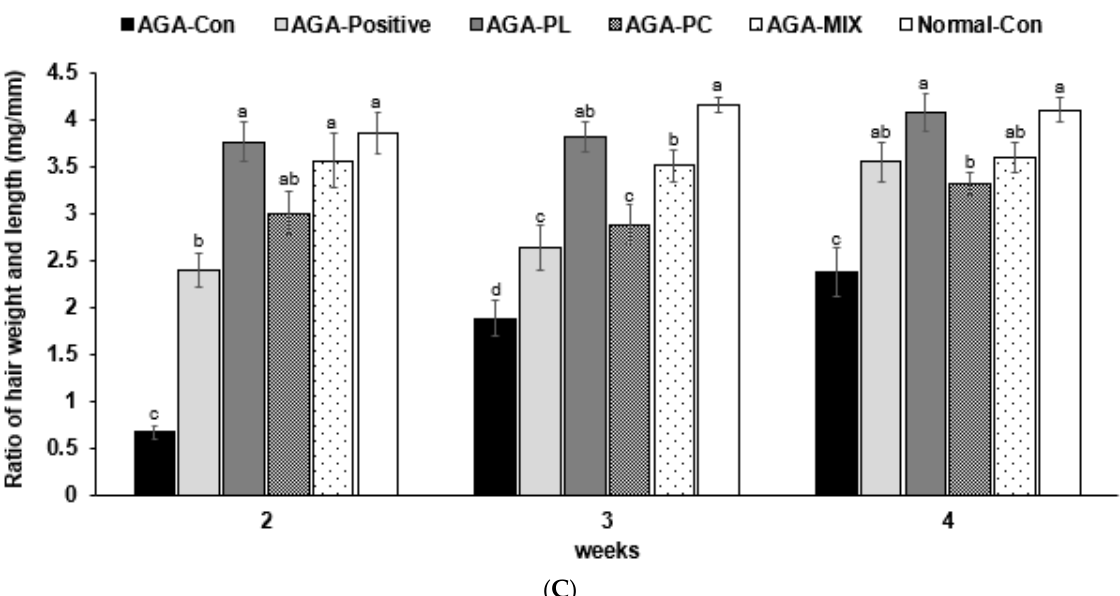
Figure 3. Severities of AGA symptoms. ( A ) Changes in AGA symptoms of dorsal skin lesions between treatment start and finish on intervention day 28. ( B ) Evaluation of average hair growth statuses of clinical AGA symptoms from treatment start to finish. ( C ) The ratio of hair weight to the length of the 30 hairs on the 2nd, 3rd, and 4th week. AGA was induced with the application of 0.5% testosterone propionate solution on the back of mice, and AGA-induced mice orally consumed 0.1% PL, 0.1% PC, or 0.1% mixture of PL and PC (1:1, w / w ) in a 43% fat diet (HFD), called AGA-PL, AGA-PC, or AGA-MIX groups, respectively. AGA-induced mice were daily applied with 2% finasteride on the back, as AGA-Positive (positive control). AGA-Positive and AGA-Con (control) mice had 0.1% cellulose (no effective activity in AGA treatment) in an HFD. Normal-Con did not induce AGA and consumed 0.1% cellulose in an HFD. All mice had an 8-week treatment. Bars and error bars represented means and standard deviations (N = 11 or 12). a,b,c,d Different letters on the bars indicate a significant difference as per a Tukey test at p < 0.05, and no or the same letters indicate no significance between the groups. Table 2. Sex hormones, cholesterol, and triglyceride concentrations in the circulation.